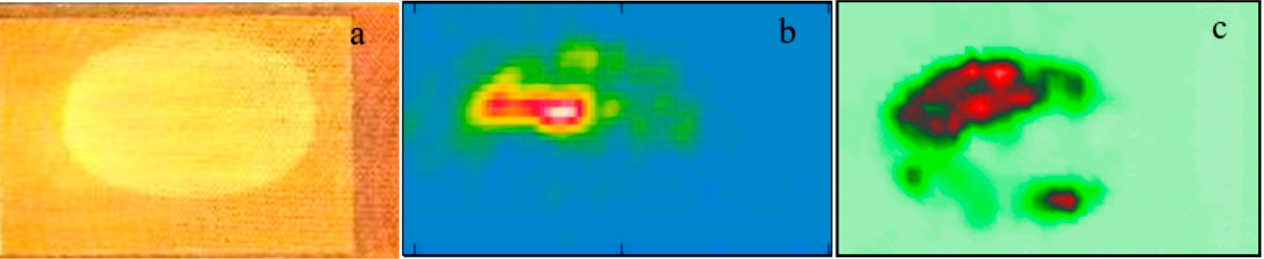
Figure 10. Imaging of the oval delamination ( a ) in smart structure: nonlinear AE ( b ) and laser vibrometry image ( c ). A high spatial resolution of the nonlinear AE imaging is also demonstrated in Figure 11. The mm-size contour details of the complex shape delamination (5 × 10 mm 2 , Figure 11a) in the multiplied GFRP are traced closely in the airborne HH image (Figure 11b).